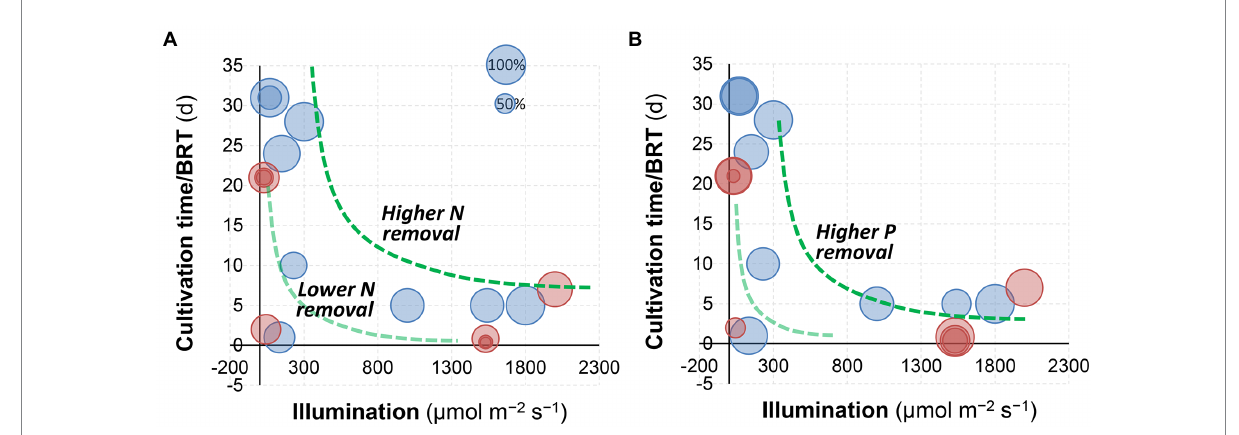
FIGURE 4 Comparison of (A) nitrogen and (B) phosphorus removal by algal cultivation at different illumination/light intensities and cultivation time. The size of bubbles represents the percentage removal. Red circles: dilution >20, and blue circles: dilution <10. Data were achieved from the literature (Adamsson, 2000; Yang et al., 2008; Chang et al., 2013; Tuantet et al., 2013, 2014, 2019; Zhu et al., 2013; Zhang et al., 2014; de Wilt et al., 2016; Jaatinen et al., 2016; Piltz and Melkonian, 2017; Chatterjee et al., 2019; Chen et al., 2020; Nguyen et al.,